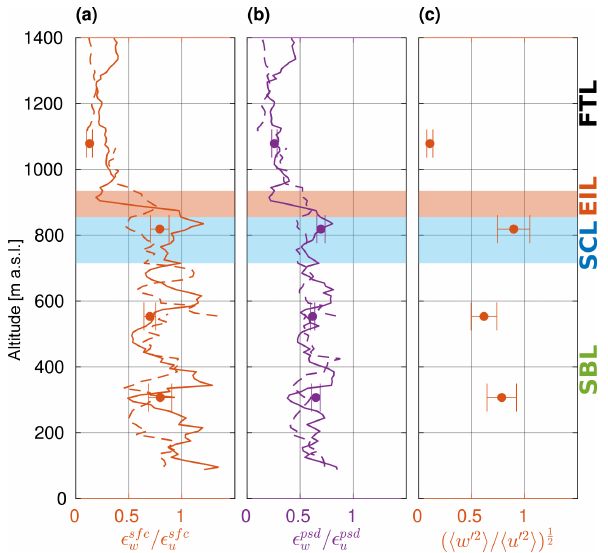
Figure 15. Anisotropy ratios in the coupled STBL (flight no. 5).